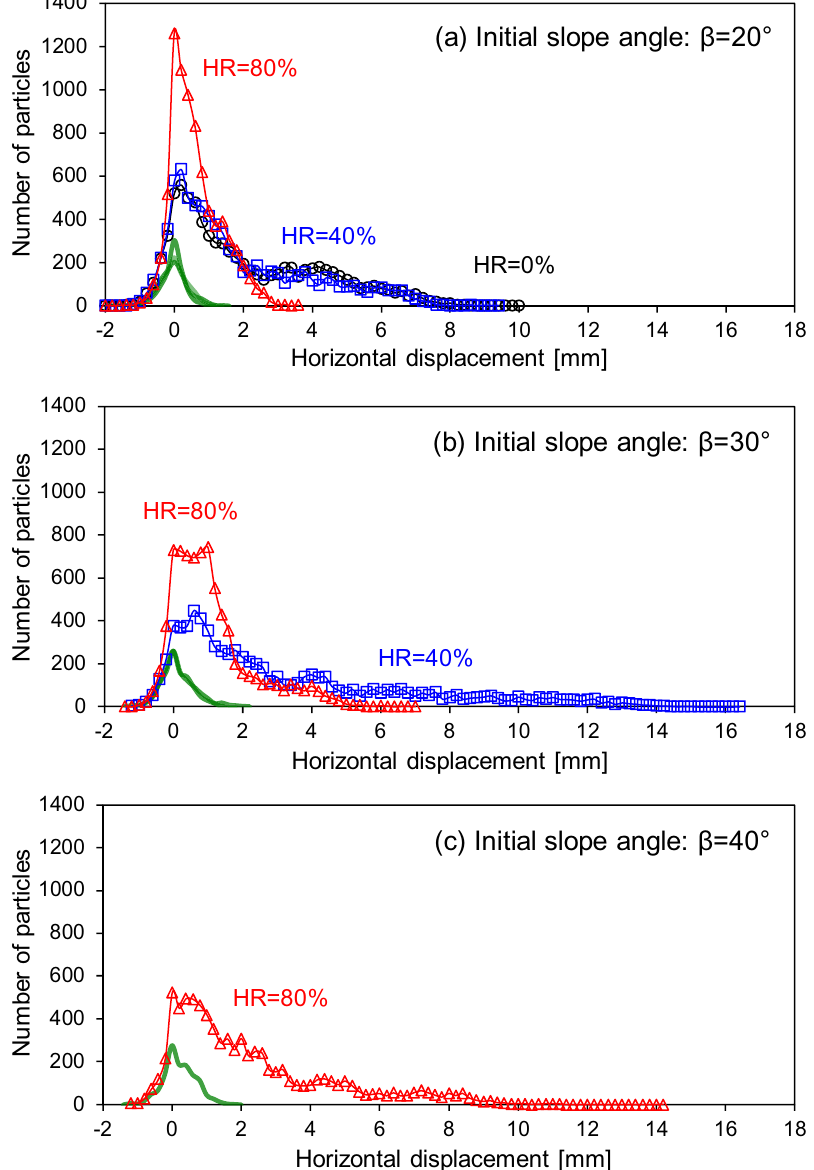
Figure 11. Histogram of horizontal displacements experienced by all non-dissolvable particles at the end of dissolution. Green lines show histograms for the ~ 2000 particles closest to the rigid wall on the right. Bin counts are connected to facilitate visualization and distinguish among HRs (Bin size = 0.2 mm for all